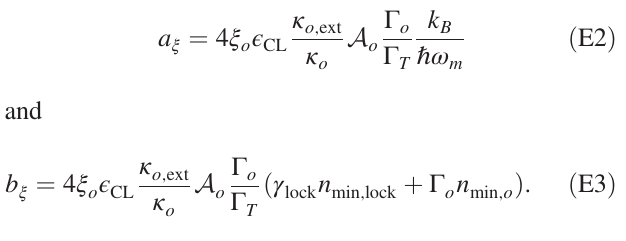
FIG. 8. Temperature sweeps. (a) Intrinsic mechanical dissipation rate γ (b) Area under mechanical peak in optical output spectrum versus T efficiency. Blue squares indicate data excluded from the fit, as the membrane mode thermalizes poorly to the base plate at low temperatures in the presence of the lock beam. (c) Area under mechanical peak in microwave output spectrum versus T of optical illumination. All error bars represent one standard